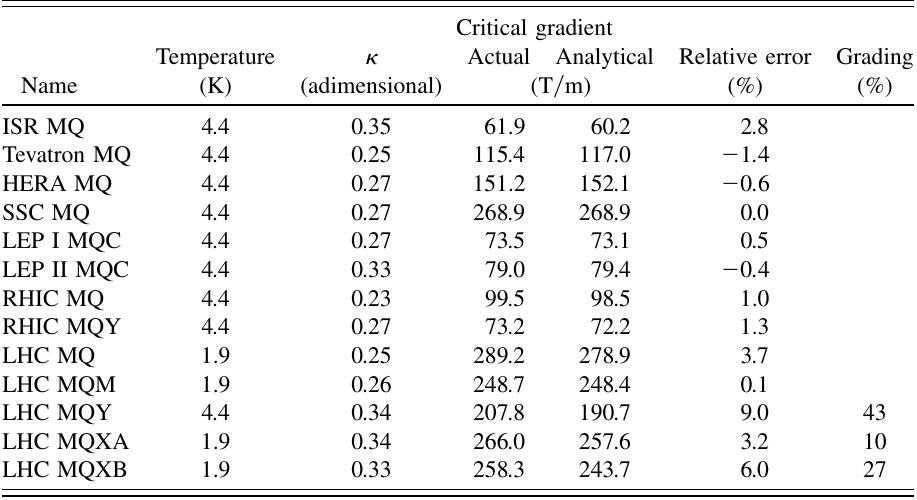
TABLE V. Actual and analytical estimates of critical gradient for 13 superconducting quadru- poles (no iron).